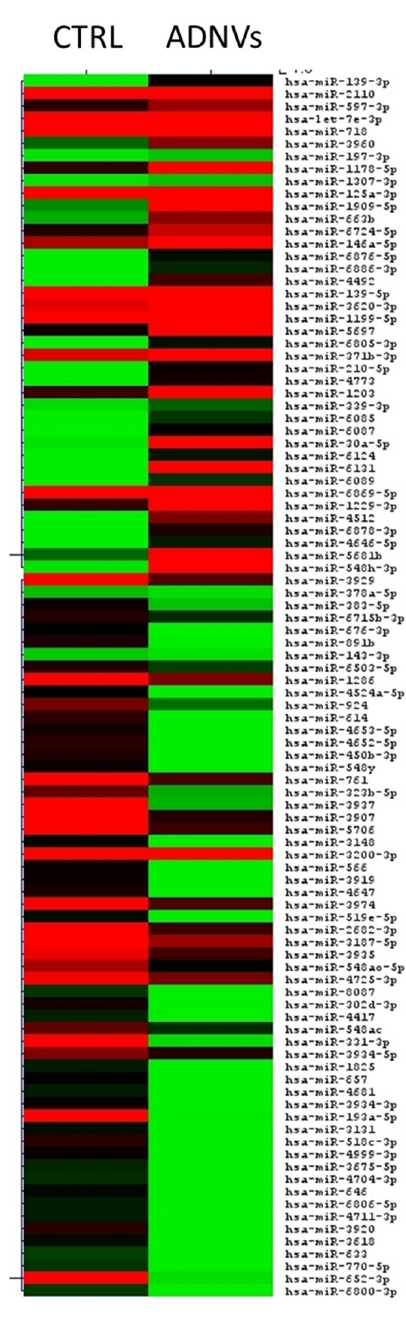
Figure 4. Heatmap of miRNAs expression in control and ADNV conditions.